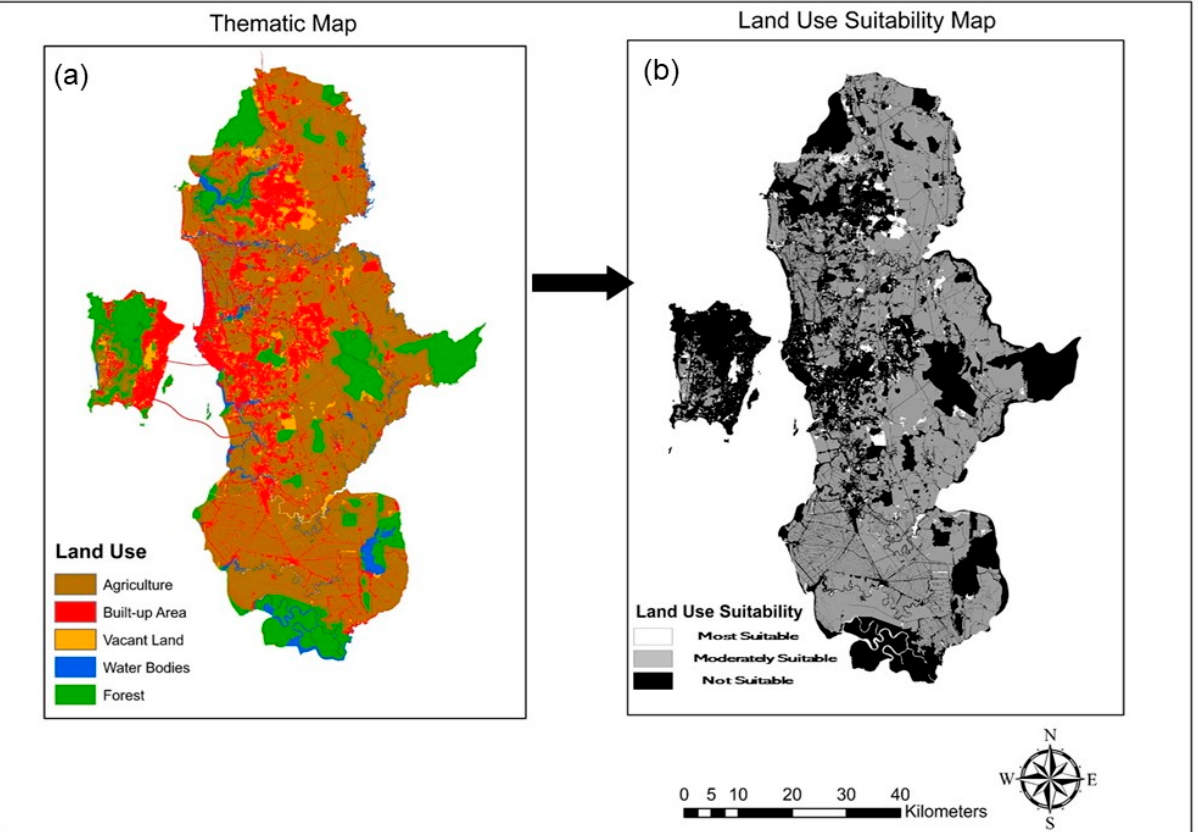
Figure 6 . ( a ) Land use and ( b ) land use suitability map in the George Town Conurbation. Figure 6. ( a ) Land use and ( b ) land use suitability map in the George Town